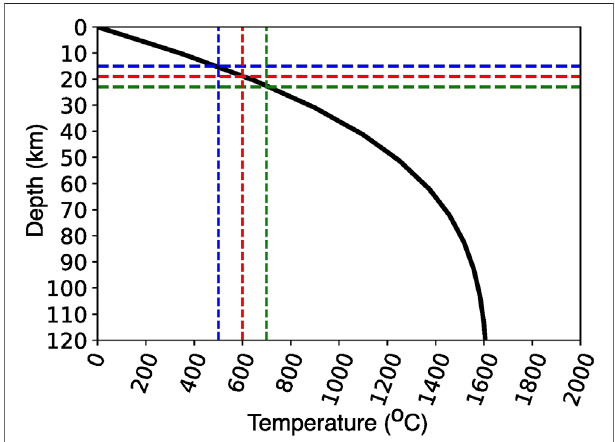
Figure A1 | The average basaltic crustal thickness relevant for different Moho-T values for a model with yield stress of 50 MPa and mantle T p of 1,600 °